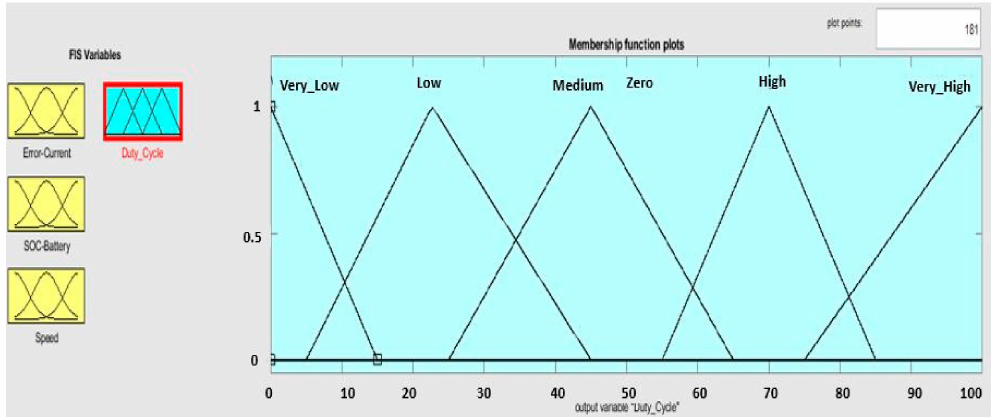
Figure 11. Membership function for duty cycle of